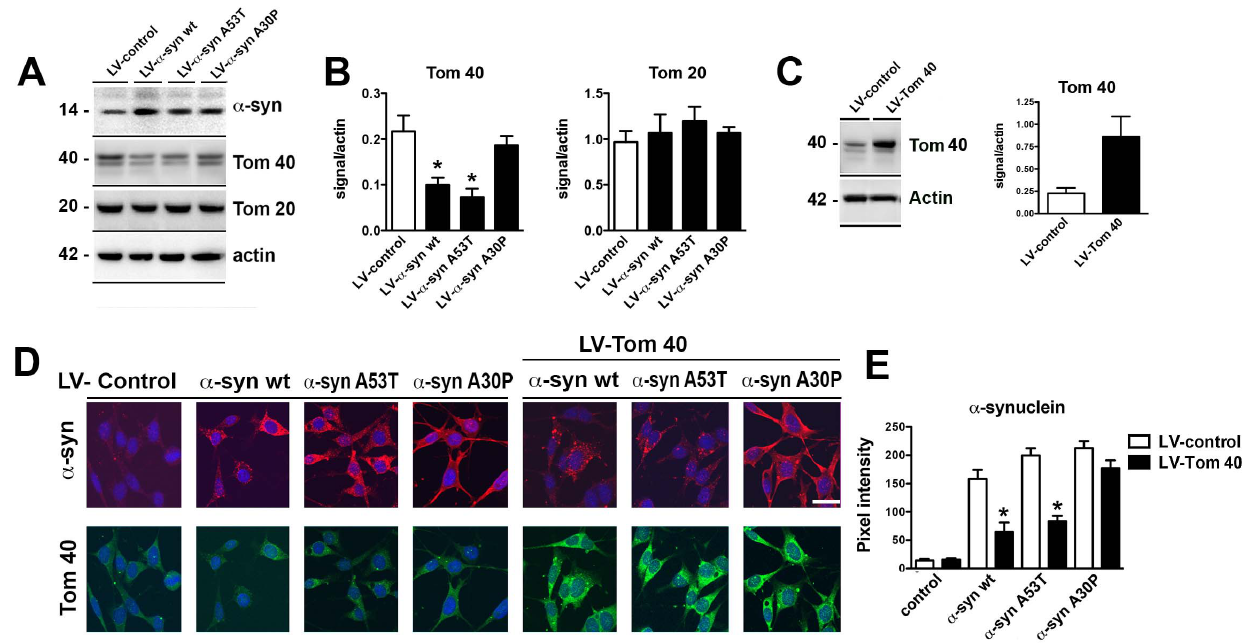
Figure 2. Tom40 is reduced in B103 cells overexpressing wild type and A53T- a -Syn. B103 neuroblastoma rat cells were infected with lentivirus encoding human a -Syn wild type (LV- a -Syn) or its mutated isoforms A53T (LV- a -Syn-A53T) and A30P (LV- a -Syn-A30P); Tom40 (LV-Tom40) or a combination of these vectors. (A) Western blot detection of a -Syn, Tom40 and Tom20 on whole cell lysates from infected B103 cells. (B) Densitometric analysis of Tom40 and Tom20 levels. (C) Efficient overexpression of Tom40 is achieved in B103 cells by infection with LV-Tom40. (D) Immunohistochemical detection of a -Syn and Tom40 in B103 cells infected with the corresponding lentiviral constructs. (E) Pixel intensity analysis of a -Syn levels, showing reduction of a -Syn in Tom40-overexpressing cells. *p , 0.05 per Student’s t test. Scale bar represents 10 m m.